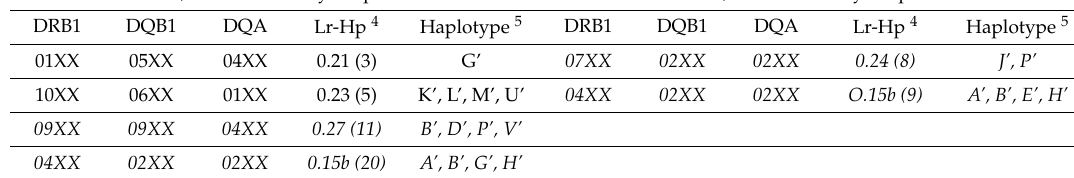
VNT categories 1 in Table S2. Only those allele-groups represented more than 2 times in the sample are indicated. 4 In brackets, number of animals with the indicated haplotype within each group ( 1,2 or 3 ). 5 As in Table 3. In italics, allele-group combinations (Low-resolution Haplotypes, Lr-Hp) represented by a greater number of animals within each group ( 1,2 or 3